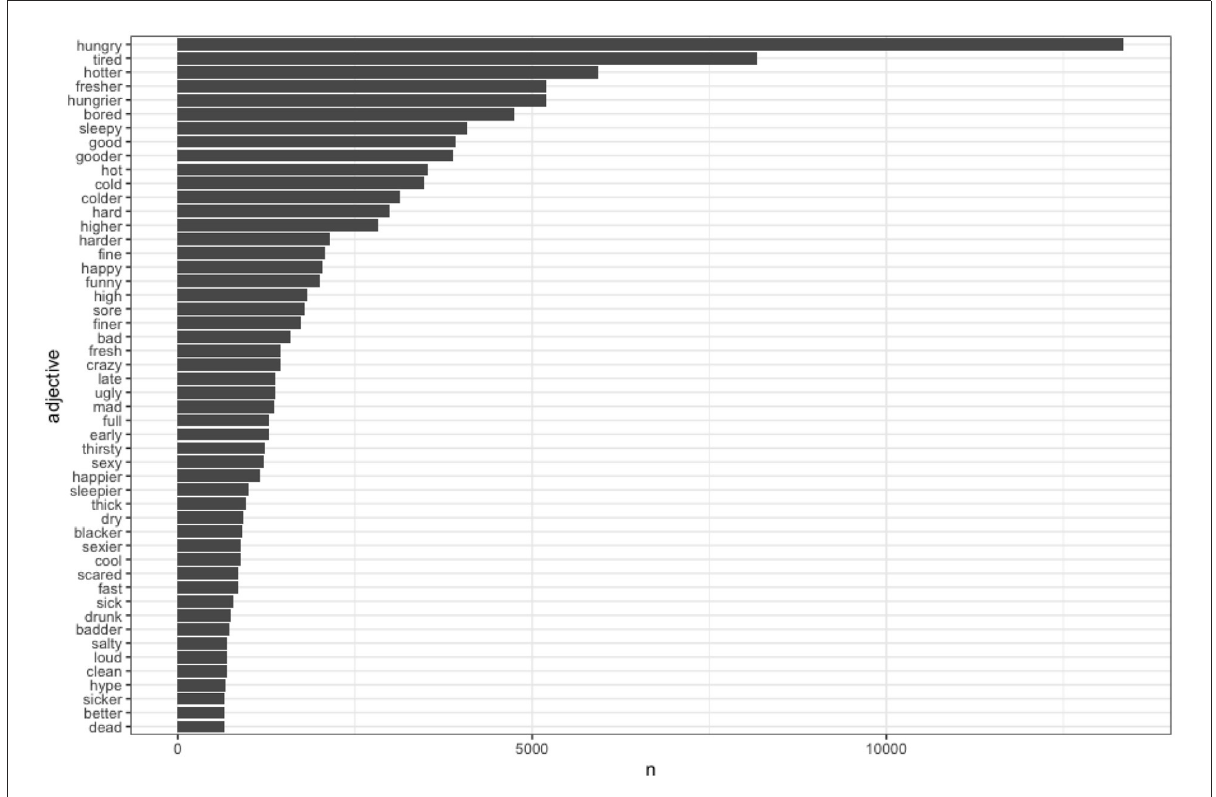
FIGURE4 Fifty most common adjectives (normalized spelling).